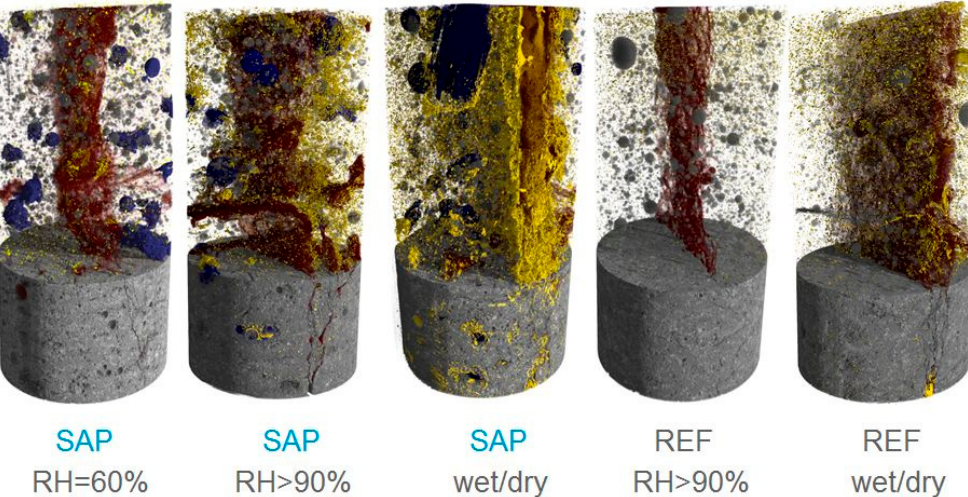
Figure 8. SAPs are able to stimulate and promote the precipitation of healing products in a crack, as was visualized by means of X-ray computed microtomography, redrafted after [190] (© 2016 Elsevier). Legend: grey concrete and pores, red crack, blue macro pores with superabsorbent polymers and yellow formed healing products after being stored for four weeks in a relative humidity of 60% (RH = 60%), more than 90% (RH > 90%) or in wet/dry cycles (1 h in water and 23 h in standard laboratory conditions) (wet/dry).